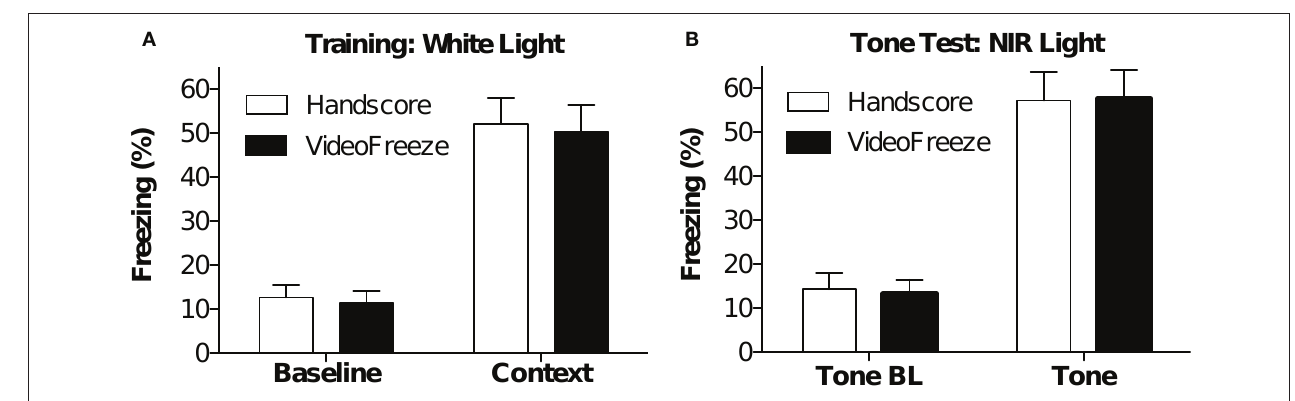
Test. Freezing during the tone baseline (Tone BL, first 2 min) and during the tone (last 3 min) is depicted. In all cases, VideoFreeze estimated the means error nearly